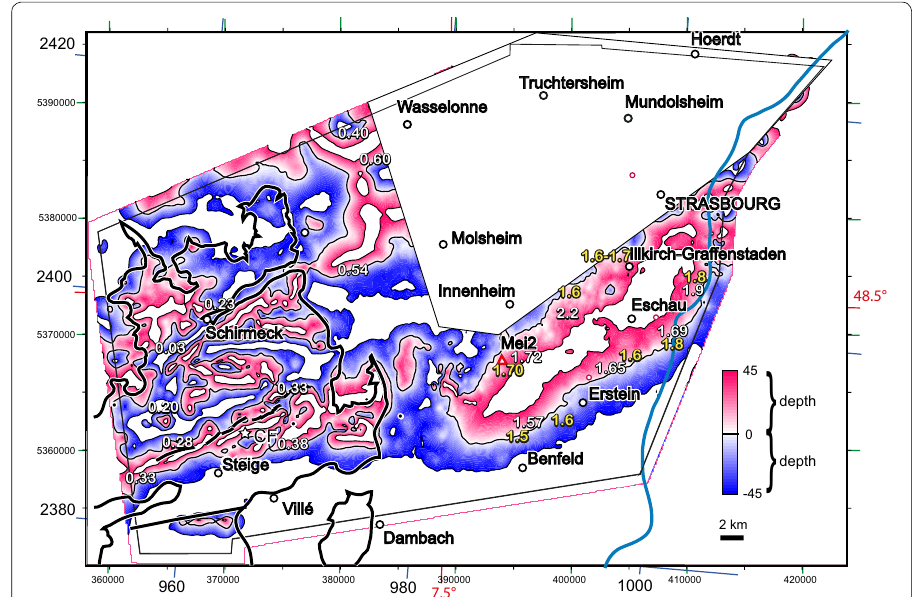
Fig. 7 Tilt map [arctg (vertical derivative/horizontal derivative)] of the Magnetic anomalies reduced to the pole. The black 0 line indicates the structure boundaries when the structures are subvertical. The width of the 45° to 45° belt provides information on the depth of the roof under the flight level. The recalculated − + depths below the surface are indicated in white. The depths values in yellow were obtained on the reduction to the pole using the Vacquier method